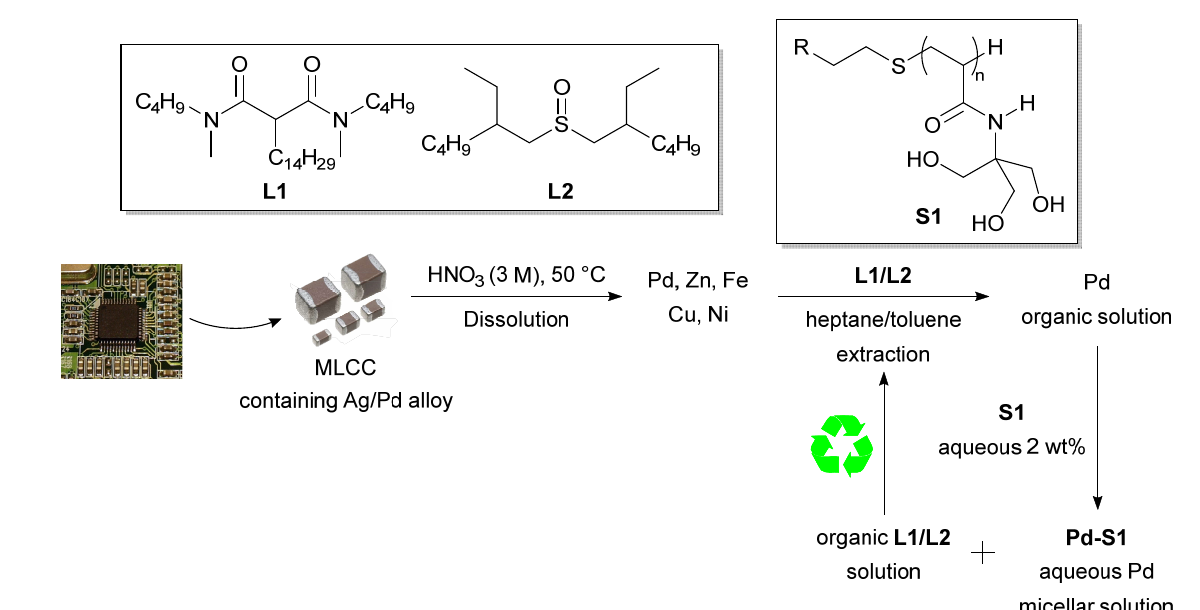
Figure 9. Micellar back-extraction of recovered palladium [98]. Reproduced with permission [98]. The group then explored the catalytic activity of their micellar palladium solution.